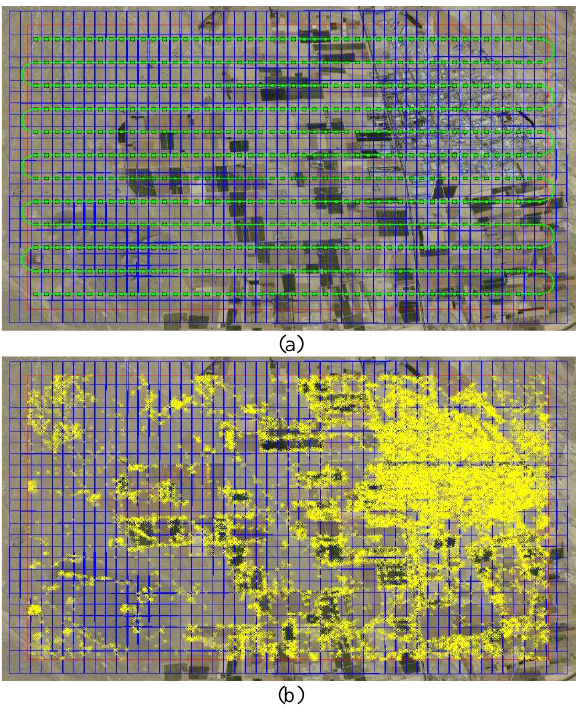
Figure 4. The geo-database that is used in the vision-aided navigation system a) the reference image and planned mission and b) the SURF keypoints